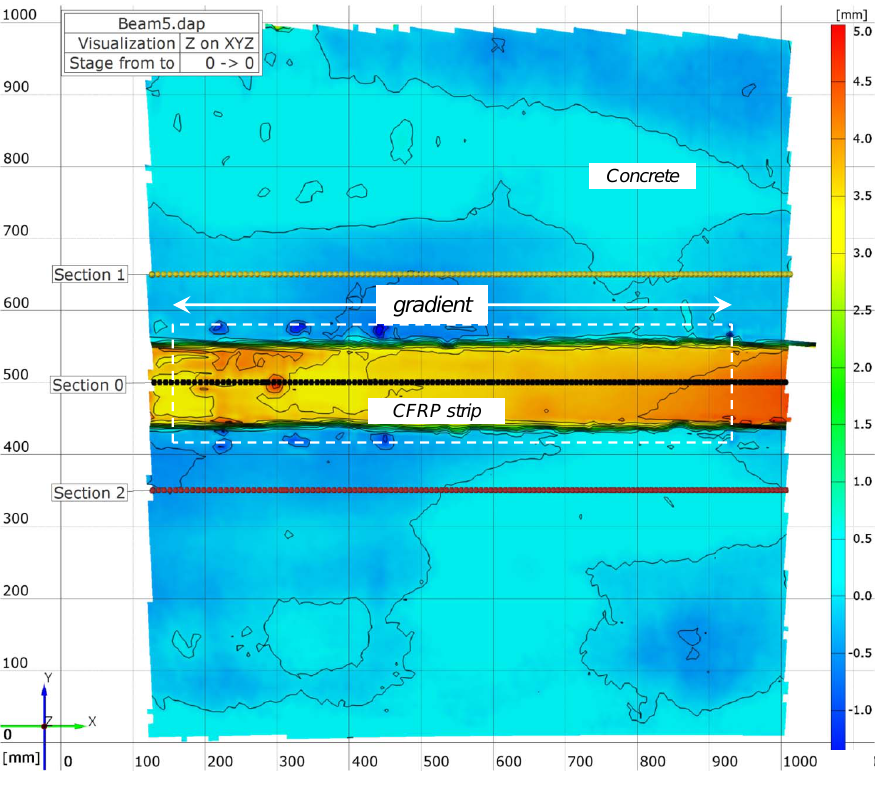
Figure 4. Image correlation measurements before the loading-out-of-plane isolines (Beam